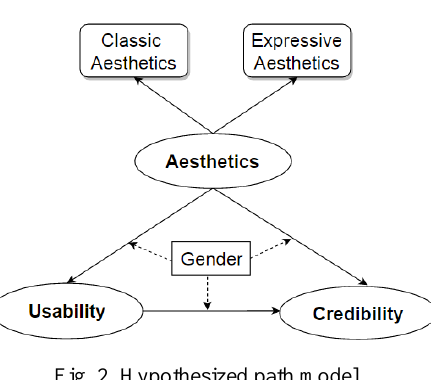
Fig. 1. Systematically designed user interfaces